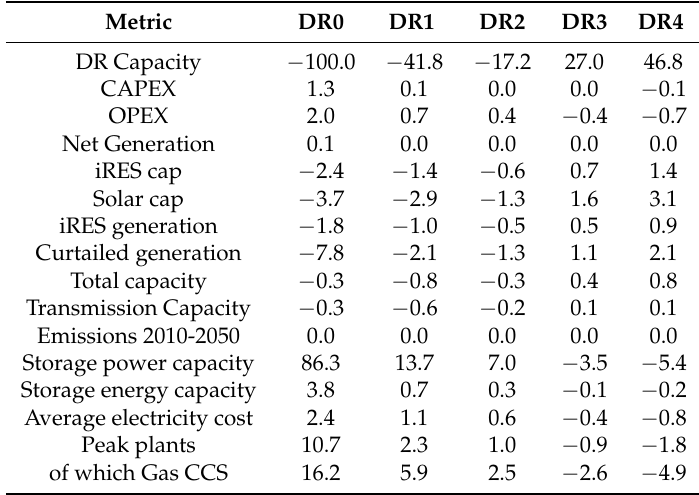
Table 3. Relative differences of each sensitivity case in percentage with respect to the reference case DRB